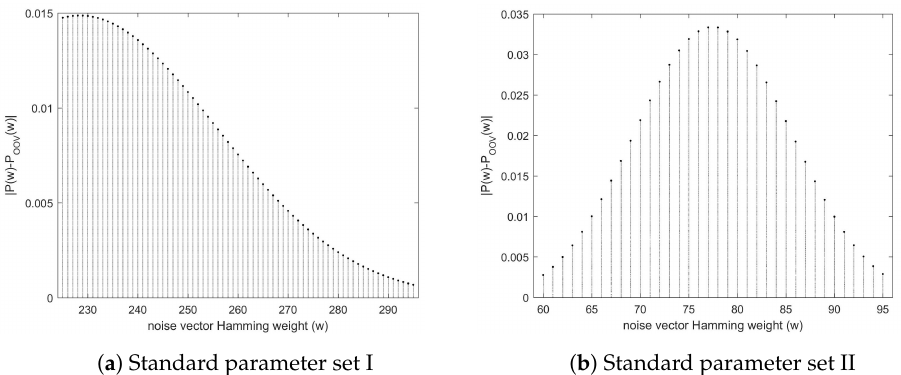
Figure 8. The exact error of the P OOV